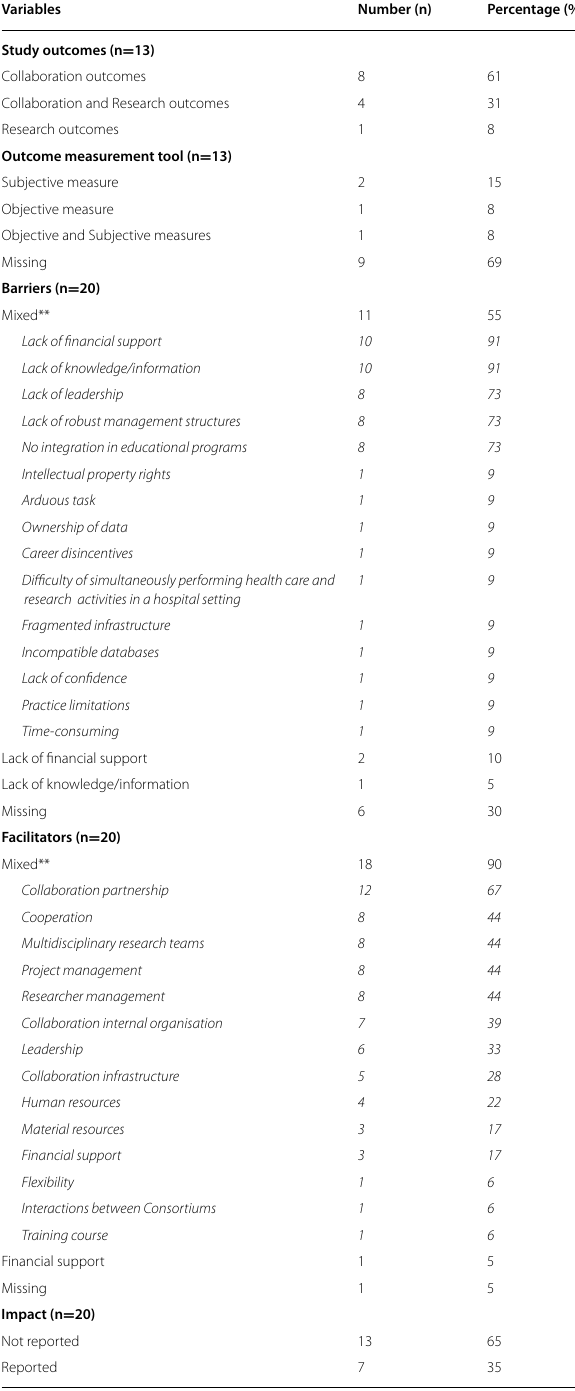
Table 3 Characteristics of